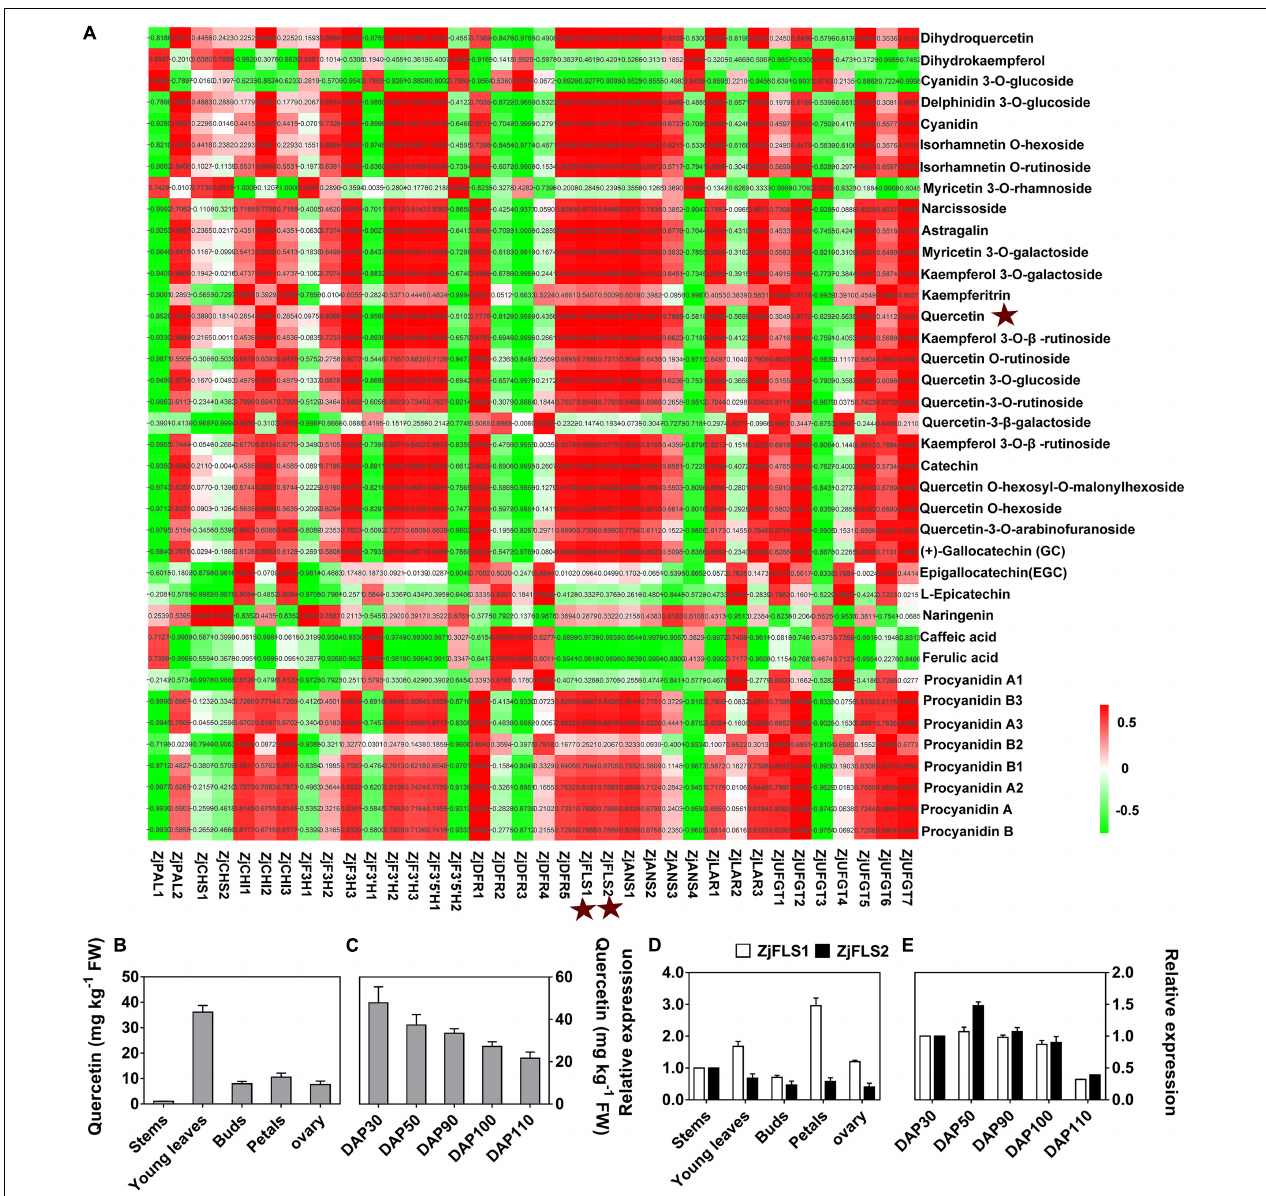
FIGURE 5 | Correlation analysis of flavonoid metabolites and flavonoid-related genes. (A) Correlation analysis between flavonoid content and flavonoid-related gene expression. (B) Quercetin content in different tissues. (C) Quercetin content during jujube fruit skin development. (D) Relative expression levels of ZjFLS1 and ZjFLS2 in different tissues. (E) Relative expression levels of ZjFLS1 and ZjFLS2 during jujube fruit skin